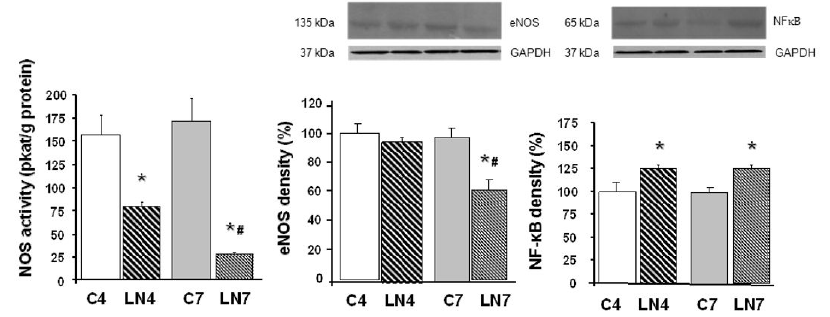
Figure 6. E ff ect of 4- and 7-week N G -nitro-L-arginine methyl ester (L-NAME) treatment on NO synthase (NOS) activity, endothelial NOS (eNOS) protein expression and nuclear factor-kappaB (NF- κ B, p65) protein expression in the cerebellum. Group treated with L-NAME for 4 weeks (LN4) and age-matched controls (C4), group treated with L-NAME for 7 weeks (LN7) and age-matched controls (C7). * p < 0.05 compared to age-matched controls, # p < 0.05 compared to LN4.